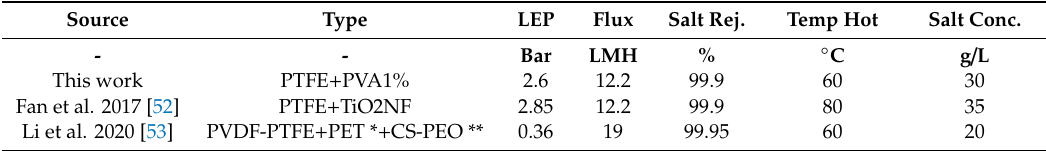
Table 4. Comparison of this work to previous research. * PET—Polyethylene terephthalate, ** CS-PEO—chitosan-polyethylene